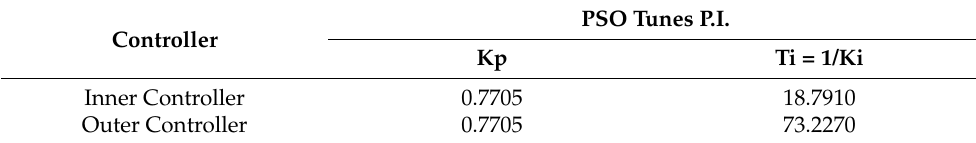
Table 6. PSO-based P.I. controller parameters.